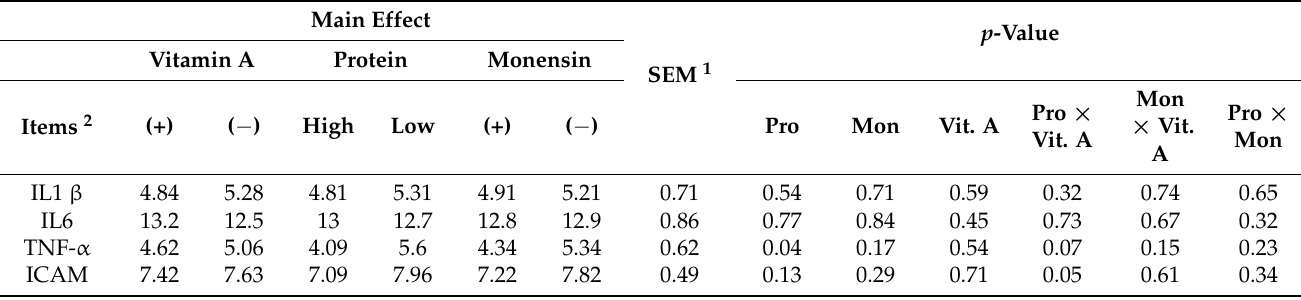
Mon = monensin; Vit. A = dietary vitamin A; Pro × Vit. = dietary crude protein and vitamin A interaction; Mon × Vit. = monensin and dietary vitamin A interaction; Pro × Mon = dietary crude protein and monensin